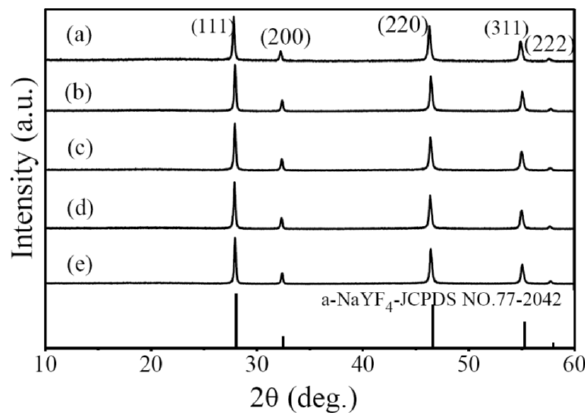
Figure 2. XRD patterns of the as prepared ( a ) Eu 3+ -, ( b ) Tb 3+ -, ( c ) Ce 3+ -, ( d ) Er 3+ -, and ( e ) Tm 3+ -doped α-NaYF 4 samples.